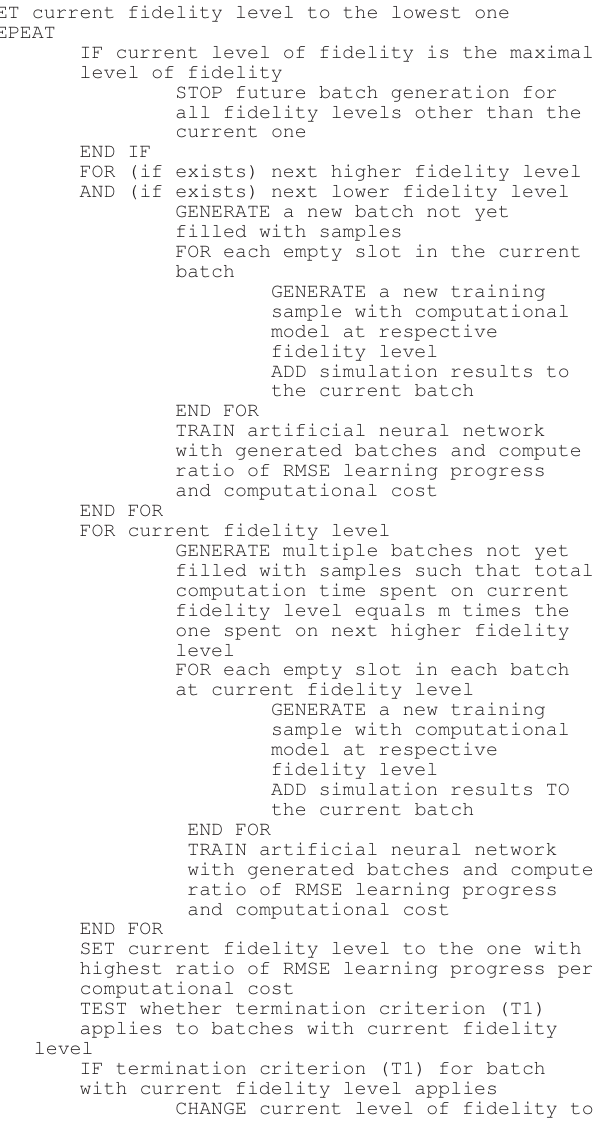
TABLE 3 | Pseudocode for bidirectional multi-fidelity training. SET current fidelity level to the lowest one REPEAT IF current level of fidelity is the maximal level of fidelity STOP future batch generation for all fidelity levels other than